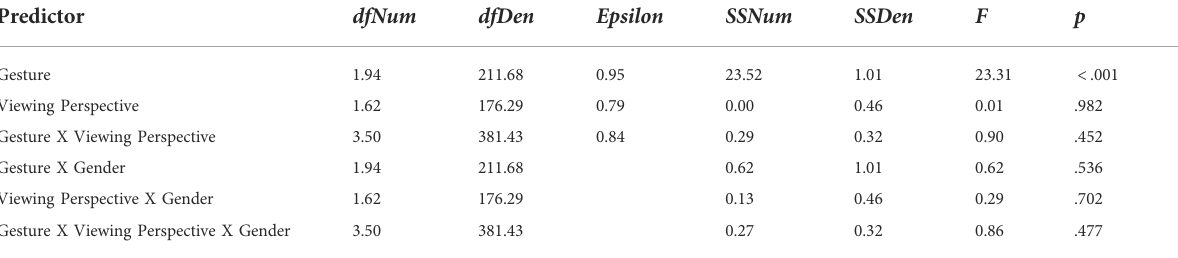
TABLE 2 Results of the mixed-measures ANOVA for the perceived animacy of the robot. Predictor dfNum dfDen Epsilon SSNum SSDen